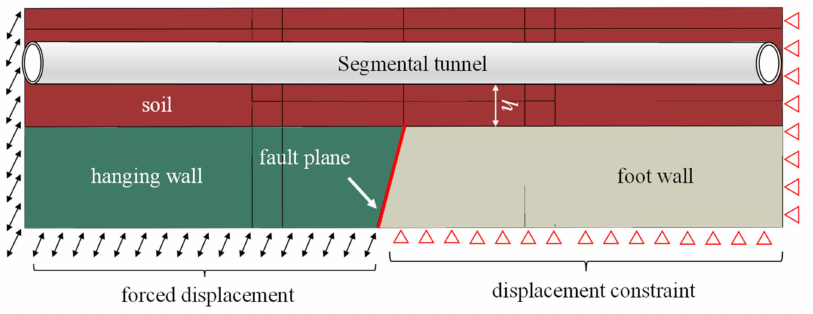
Figure 5. Boundary conditions of the numerical model and the fault simulation